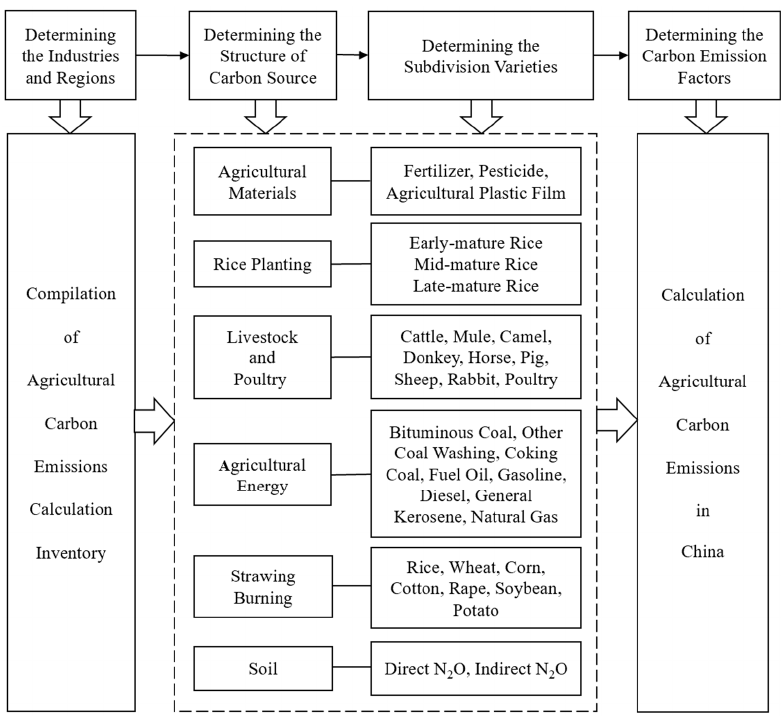
Figure 1. Compilation of Agricultural Carbon Emissions Calculation Inventory.